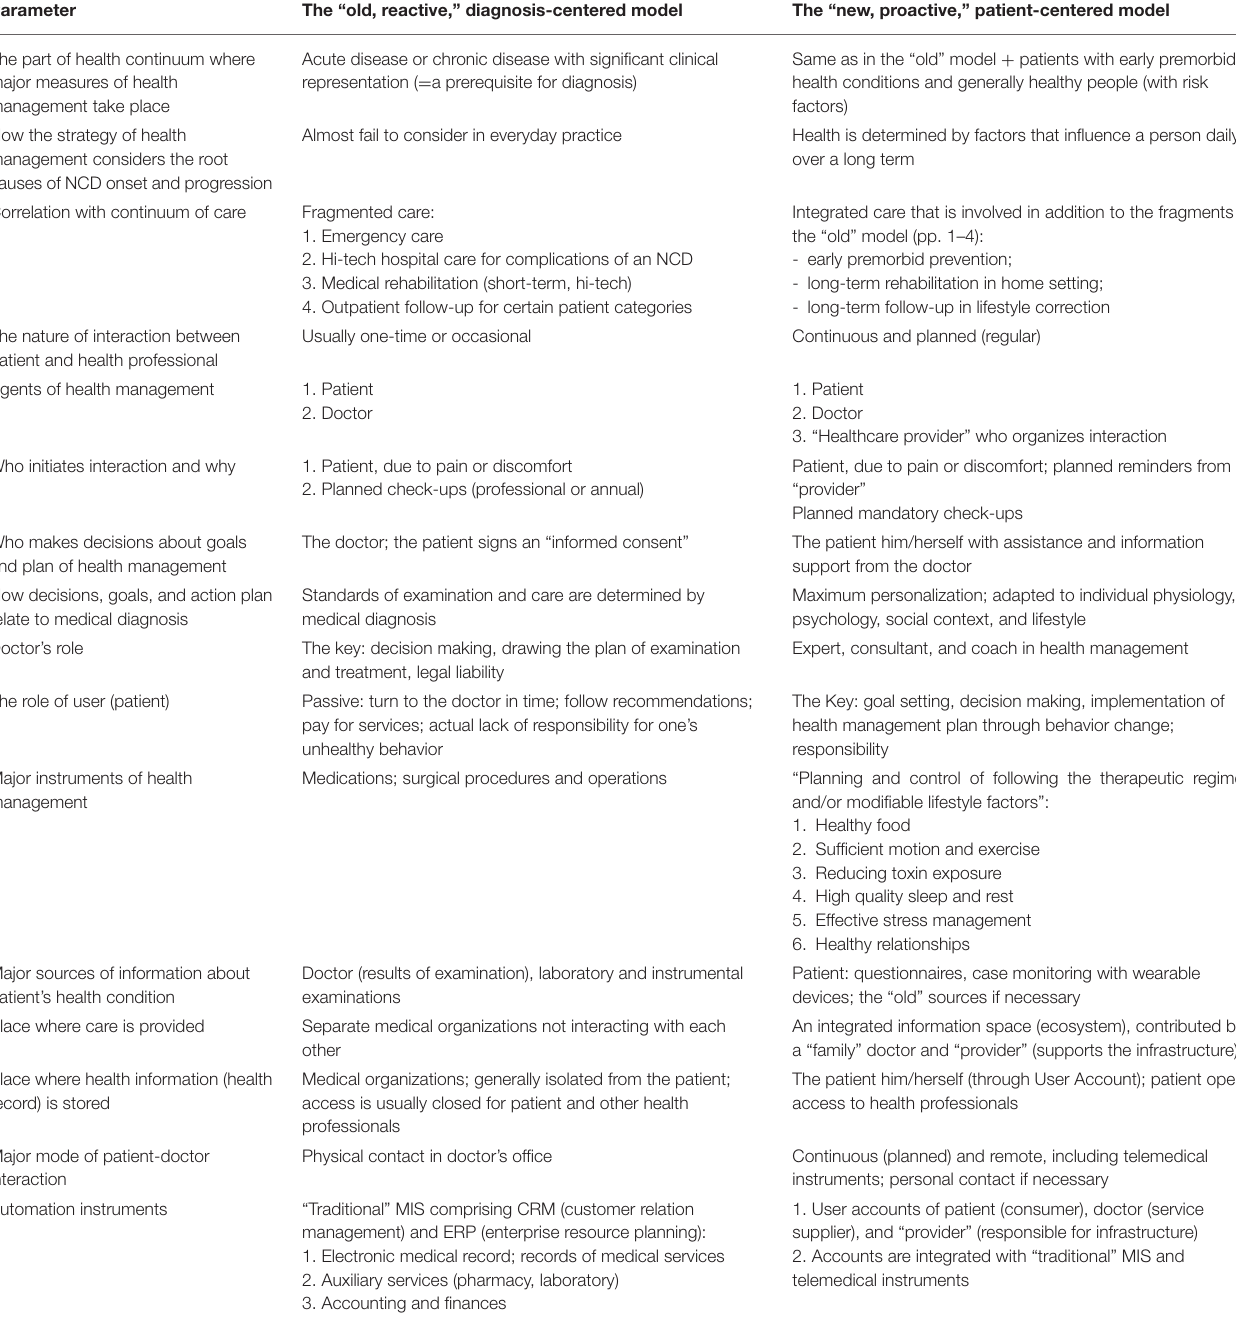
TABLE 3 | Comparison of key parameters of diagnosis-centered and person-centered healthcare models relevant for design of AHMS. Parameter The “old, reactive,” diagnosis-centered model The “new, proactive,” patient-centered model The part of health continuum where Acute disease or chronic disease with significant clinical major measures of health representation ( = a prerequisite for diagnosis) management take place